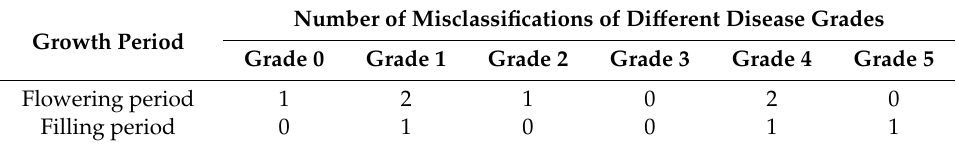
Table 1. The number of misclassifications of di ff erent disease